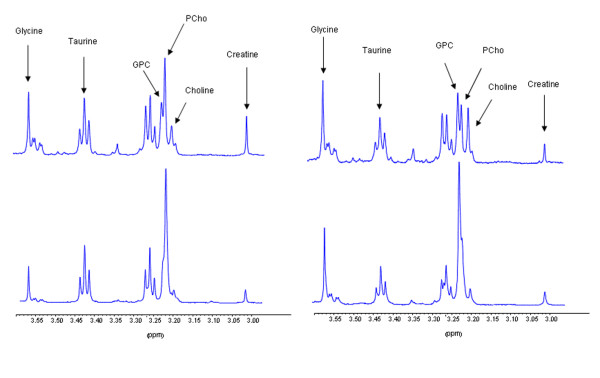
Mean HR MAS MRS spectra from human tissue samples and xenograft tissue. HR MAS MRS spectra (spectral region 3.6 to 3.0 ppm) of ER+/PgR+ (top left) and triple negative (top right) human tissue samples, and luminal-like (bottom left) and basal-like (bottom right) xenograft samples. Spectral assignments are provided for peaks used in quantification.